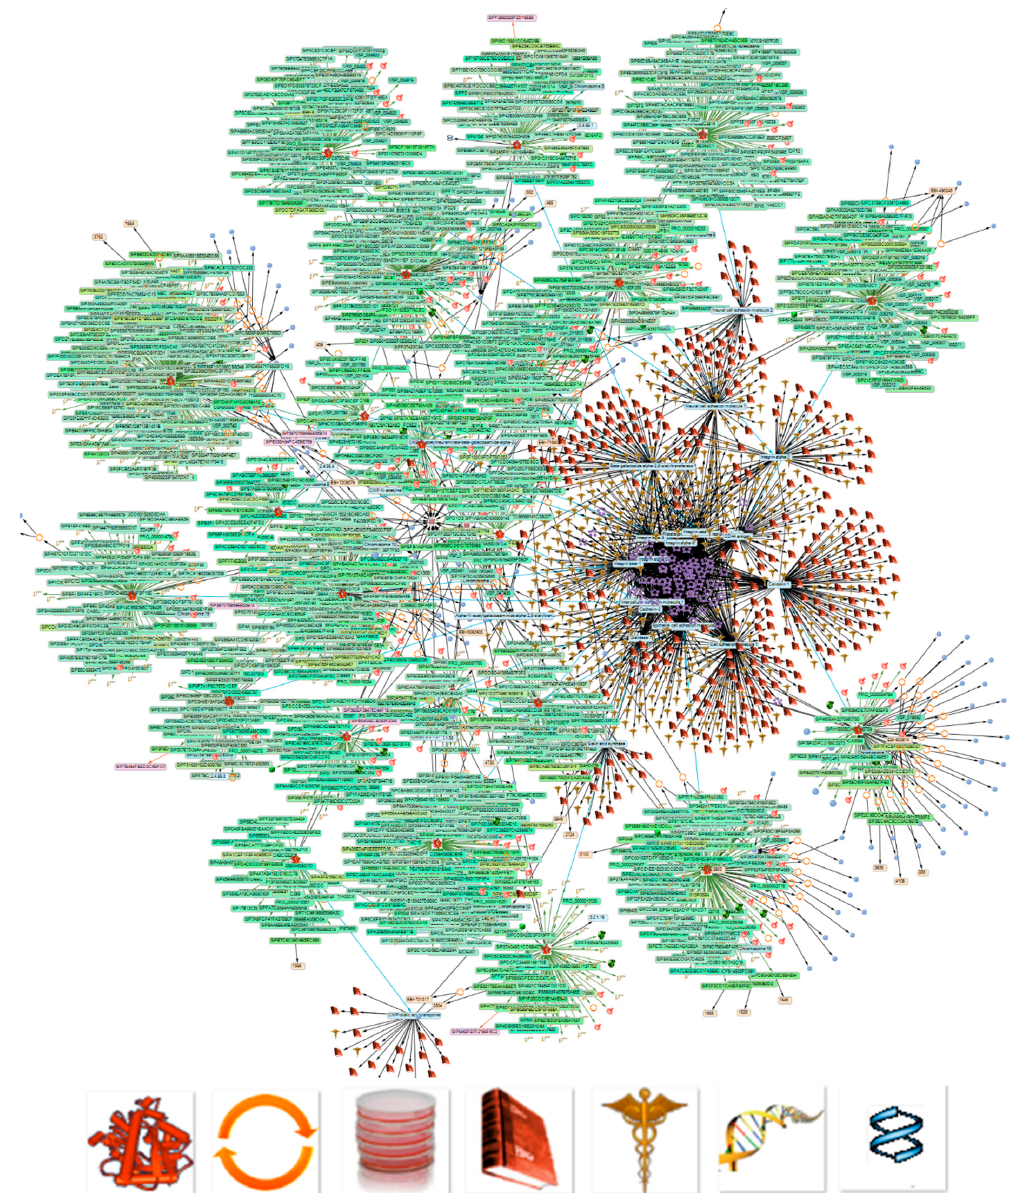
Figure 2. The results of KE-mediated searches for scientific information in reference and fact databases. The SwissProt accession numbers of the proteins shown in Table 1 were used to search for manuscripts about their sialylation in combination with further traits regarding their structures, genes, sequences, and functions. The various icons shown in the bottom line at a high magnification indicate the type of nodes (from left: protein structures, functions, cells producing the proteins, publications, diseases wherein the proteins play a role, genes, and sequences). The text within the picture becomes legible after magnification.